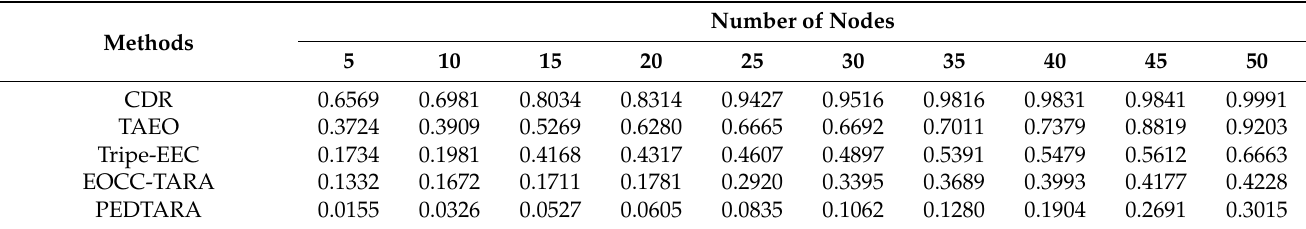
Table 3. End-to-end delay